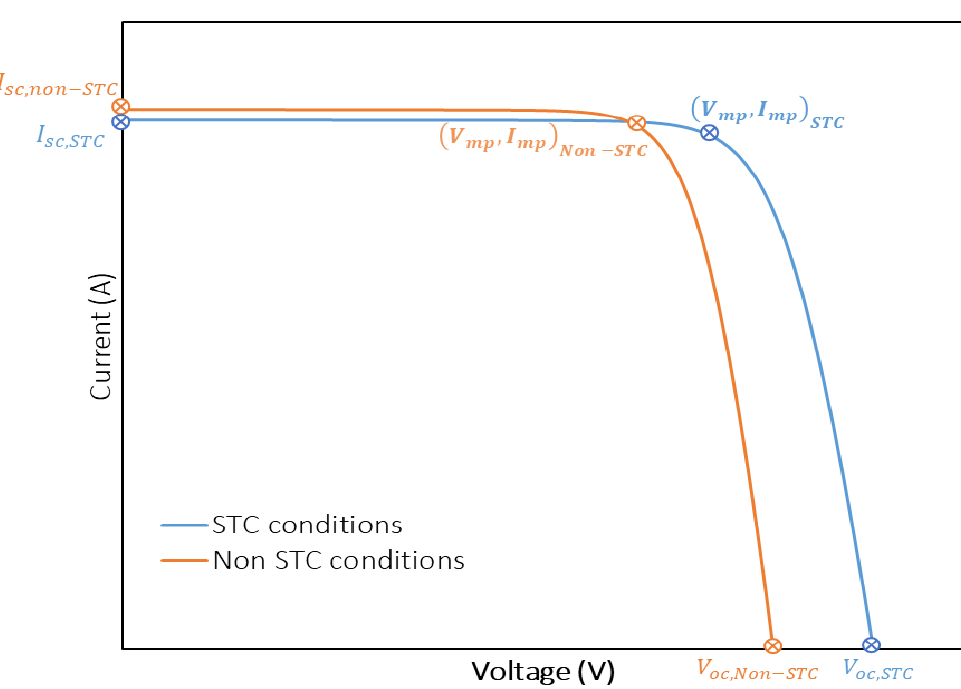
Figure 9. The characteristics and parameters of a typical I – V curve.